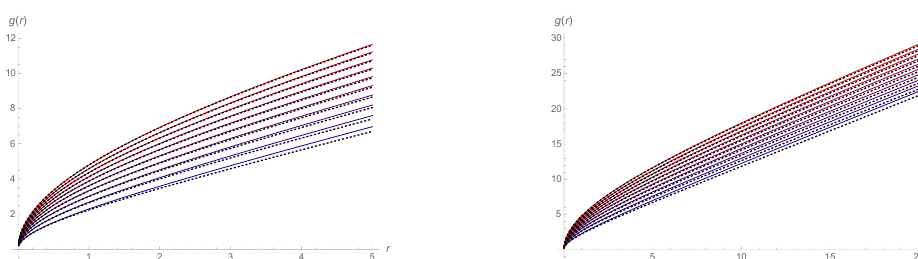
Figure 13 . Comparison between g , for A = 1 (blue) to A = 10 (red), to g 0 (dotted). We consider the ranges: a) 0 (cid:20) r (cid:20) 5 and b) 0 (cid:20) r (cid:20) 20.